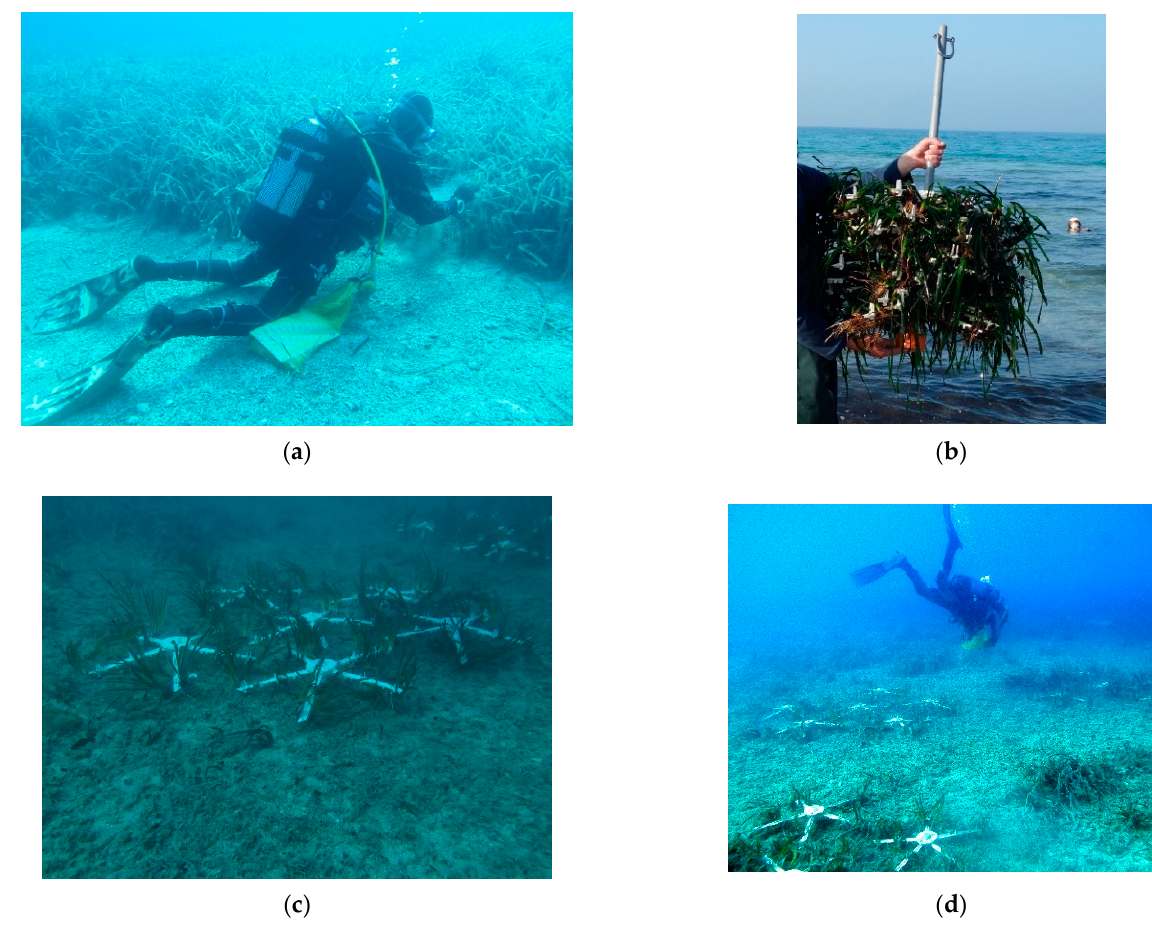
Figure 11. Pilot transplantation procedure: ( a ) identification of the donor meadow and ( b ) harvesting of cuttings, fixing of cuttings to arms (biodegradable support), ( c ) transport of the supports with cuttings to the site to be reforested and ( d ) monitoring of the transplantation.